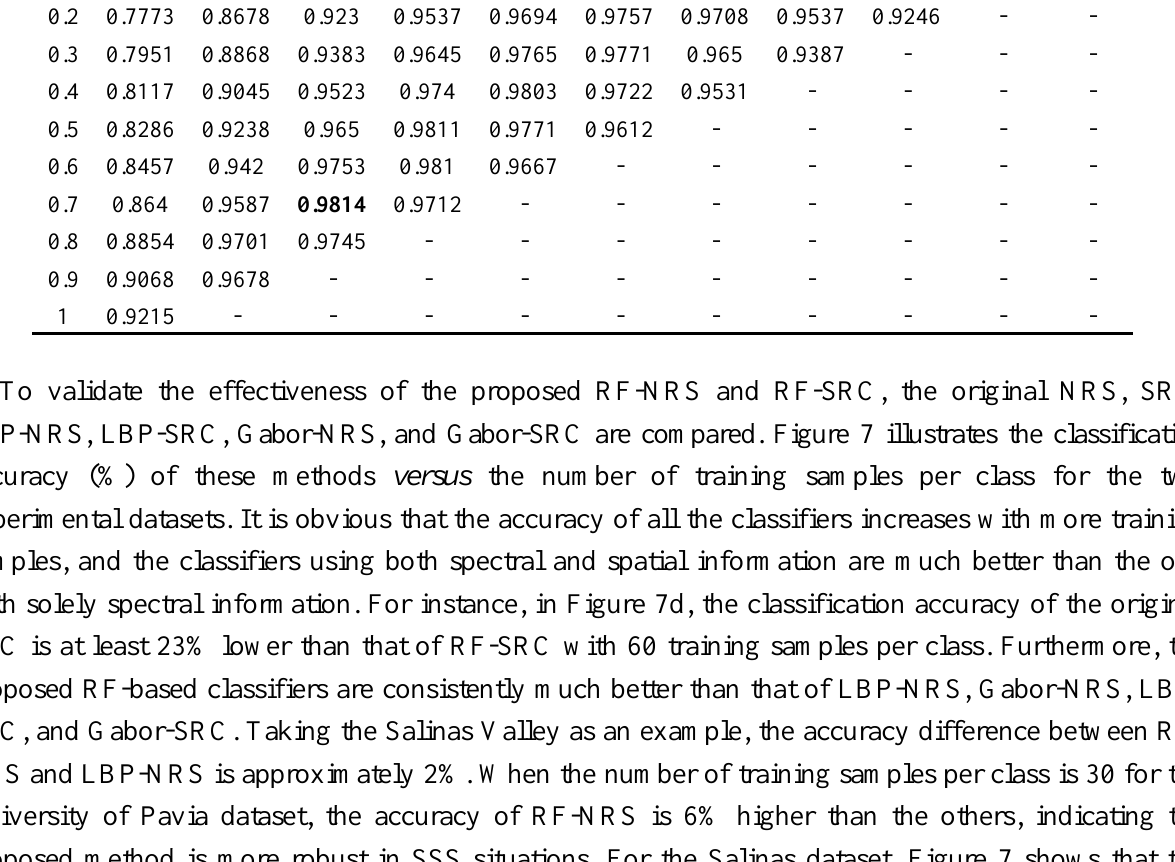
w for RF-SRC in w and 2 1